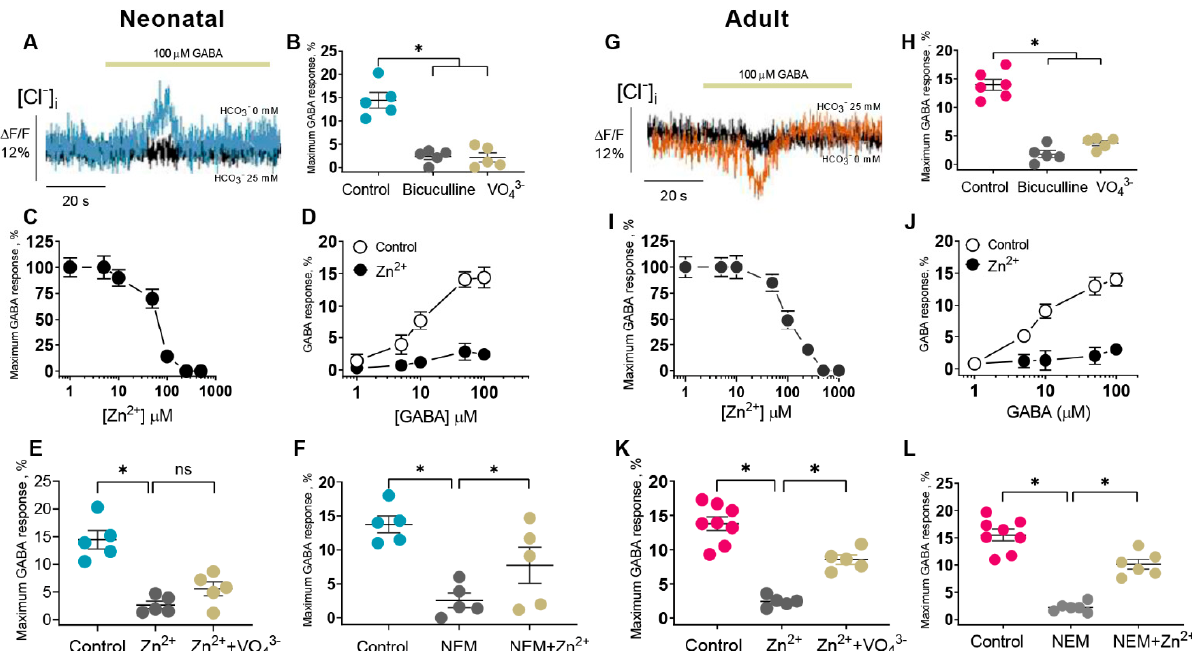
Figure 2. Zinc potency for GABA A R-mediated Cl − flux is affected from neuron development stages. ( A , G ) Corresponding MQAE fluorescence changes for SNs (P1) and (P35) recording in response to 100 µM GABA application without or with 25 mM HCO 3 − in an experimental medium, respectively. ( B ) Bar chart showing average maximum GABA response before and after 40 µM bicuculline or 25 µM VO 43 − application: Student’s unpaired t -test, p < 0.0001 ( n = 5) and p < 0.0002 ( n = 5). ( C , I ) Zn 2+ concentration inhibition curve recording for average maximum the GABA response. ( D , J ) GABA concentration activation curve recording for MQAE fluorescence changes before and after 100 µM Zn 2+ ( n = 4). ( E ) Bar chart showing average maximum GABA response before and after 100 µM Zn 2+ or 100 µM Zn 2+ + 25 µM VO 43 − application: Student’s unpaired t -test, p < 0.0002 ( n = 5) and p < 0.0062 ( n = 5). ( F ) Bar chart showing average maximum GABA response before and after 300 µM NEM or 300 µM NEM + 100 µM Zn 2+ application: Student’s unpaired t -test, p < 0.0001 ( n = 5) and p = 0.1094 ( n = 5). ( H ) Bar chart showing average maximum GABA response before and after 40 µM bicuculline or 25 µM VO 43 application: Student’s unpaired t -test, p < 0.0001 ( n = 6) and p < 0.0400 ( n = 5). ( K ) Bar chart showing average maximum GABA response before and after 200 µM Zn 2+ or 200 µM Zn 2+ + 25 µM VO 43 − application: Student’s unpaired t -test, p < 0.0001 ( n = 8) and p < 0.0001 ( n = 5). ( L ) Bar chart showing average maximum GABA response before and after 300 µM NEM or 300 µM NEM + 200 µM Zn 2+ application: Student’s unpaired t -test, p < 0.0001 ( n = 8) and p < 0.0001 ( n = 5). Data are presented as mean ± SEM. * p < 0.05, ns, not significant.